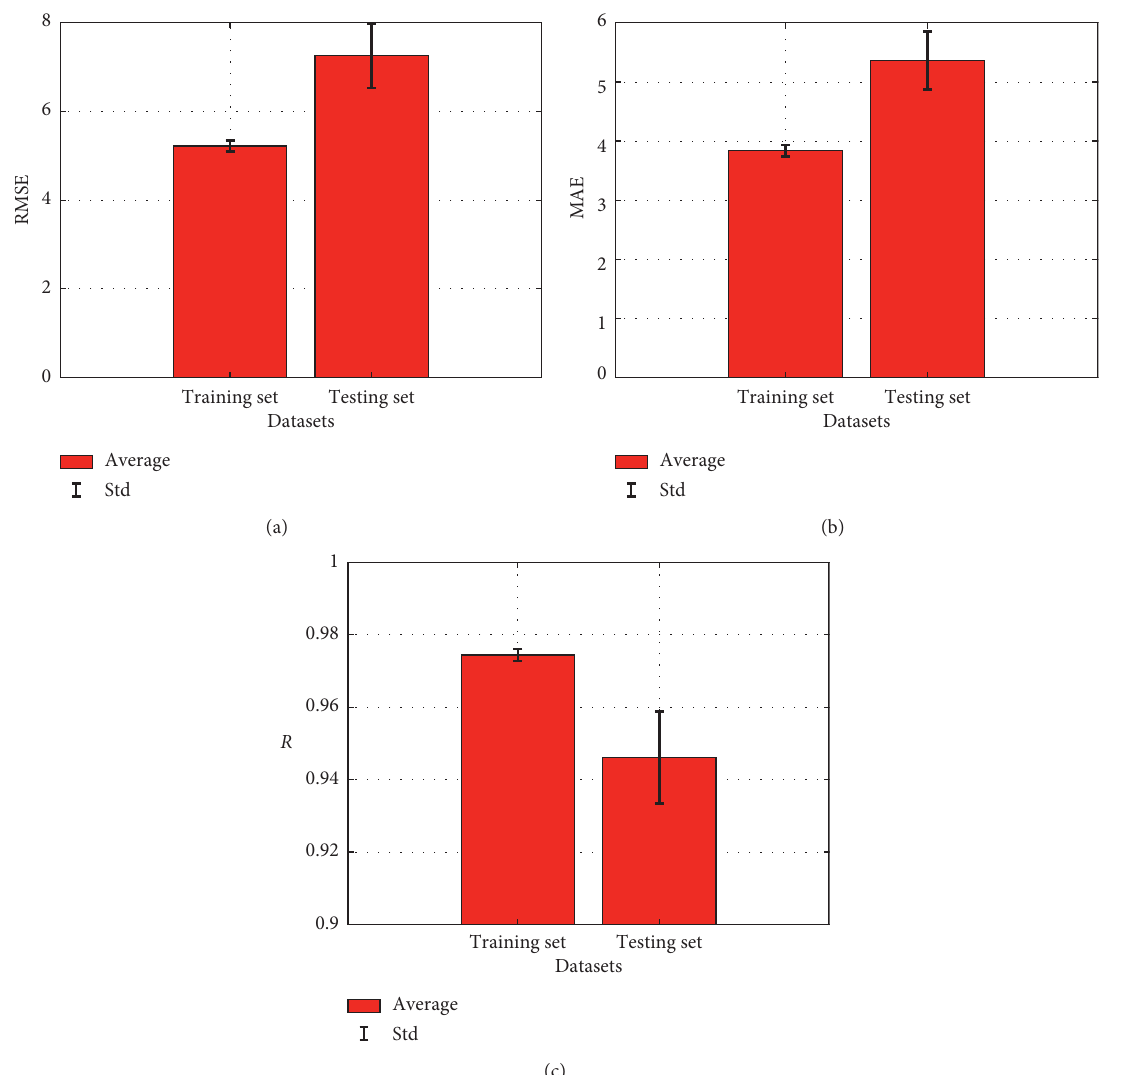
Figure 6: Analysis of the results over 500 simulations (presented in average values with standard deviation) using different RF architectures: (a) R ; (b) RMSE; (c) MAE.